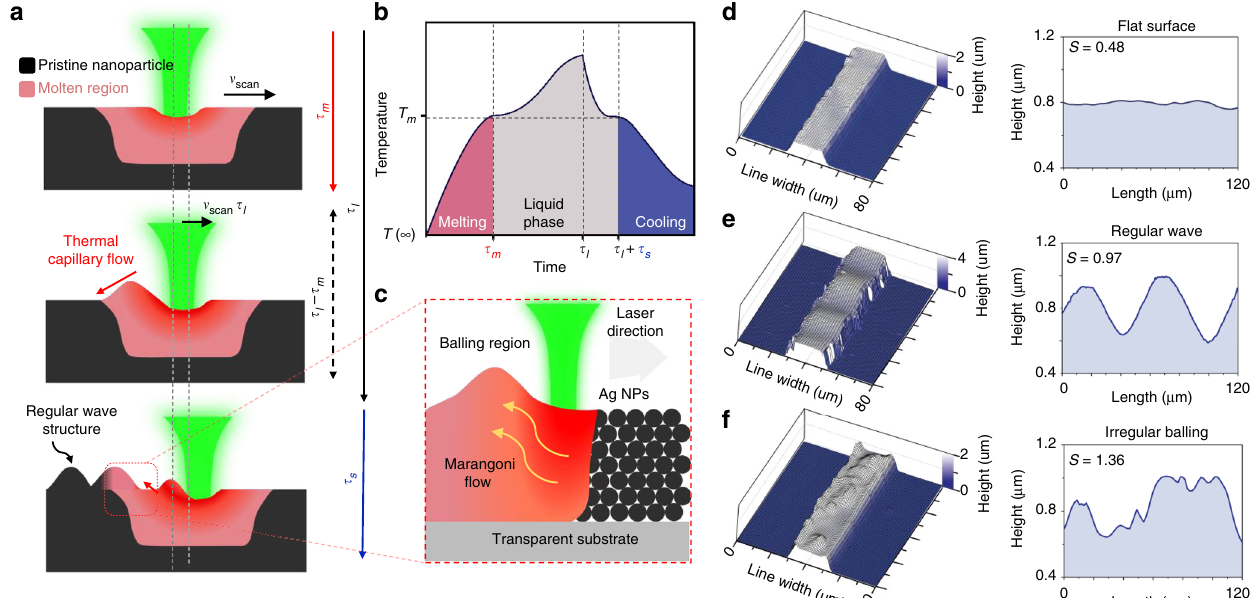
Fig. 2 Self-generated multiscale microstructure by laser-induced Marangoni fl ow. a Time scales of microthermo fl uidic phenomena under optimum conditions for regular wavy structure. b Temporal dependence of characteristic temperature pro fi le induced by single cycle of laser scanning. c Marangoni convection in molten AgNP layer induced by laser scanning. d – f 3D scanned image and surface pro fi le of AgNP layer with different laser conditions with S = 0.48 ( d ), S = 0.97 ( e ), and S = 1.36 ( f